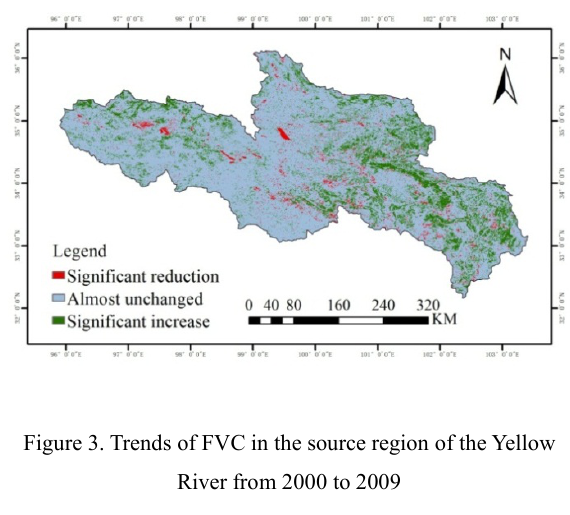
Figure 3. Trends of FVC in the source region of the Yellow River from 2000 to 2009